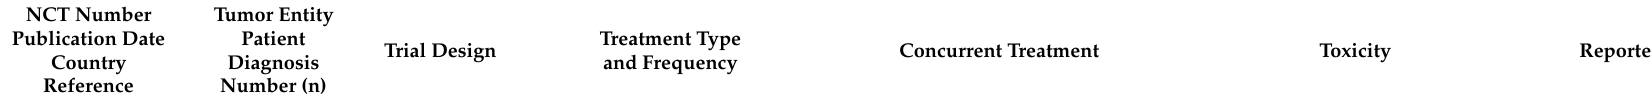
Table 2. Application of gossypol/AT-101 in combination with standard chemo- and radiation therapies in Phase I and II